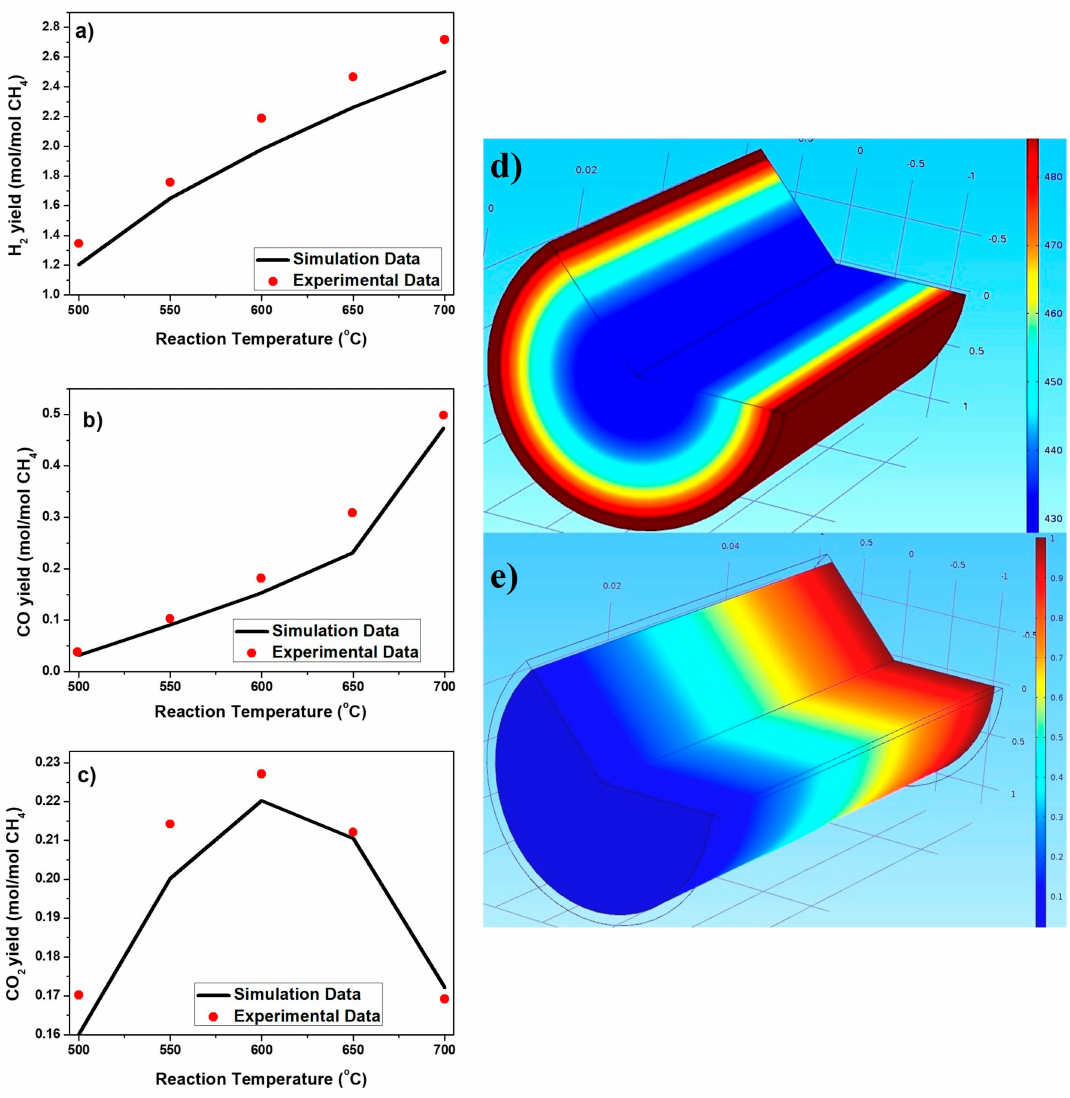
Figure 6. Validation of experimental results with the simulation data for 10%Ni/Al 2 O 3 catalyst within 500–700 ◦ C and S/C of 2 under atmospheric pressure; ( a ) H 2 yield, ( b ) CO yield, ( c ) CO 2 yield, ( d ) Catalyst bed temperature distribution and ( e ) H 2 pressure